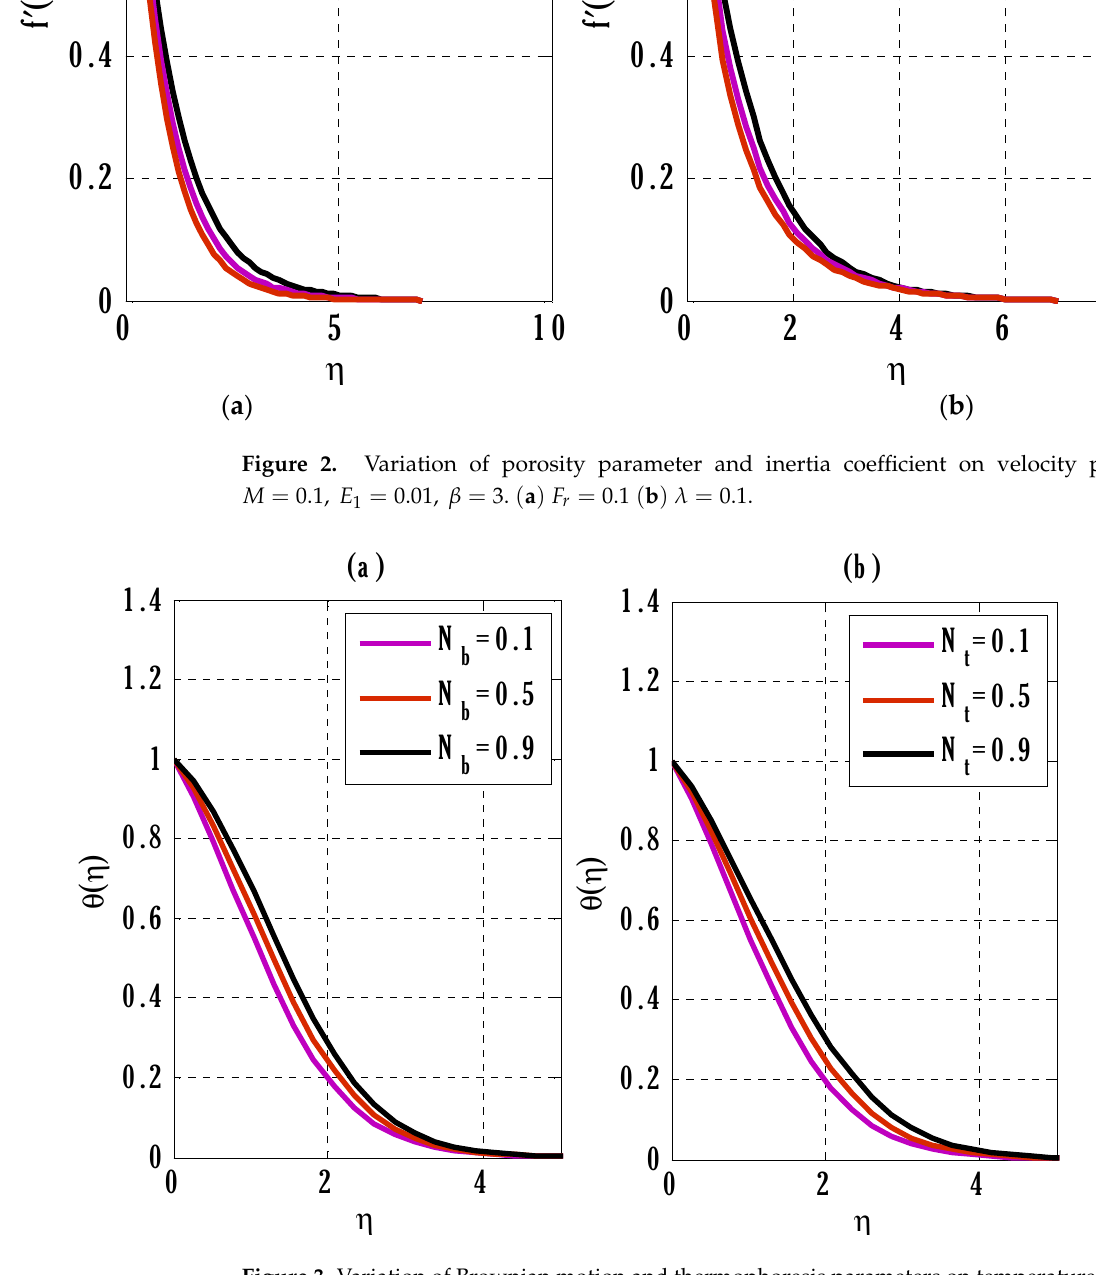
Figure 3. Variation of Brownian motion and thermophoresis parameters on temperature profile using β = 3, M = 0.1, λ = 0.1, F r = 0.1, P r = 0.7, S c = 0.5, E c = 0.4, R d = 0, E 1 = 0.01, ε 1 = 0.9, ε 2 = 0.5, γ = 0.1. ( a ) N t = 0.1 ( b ) N b = 0.1 . Figure 4 displays the temperature profile by varying the Prandtl and Eckert numbers. Temperature profile falloffs and develops by escalating the Prandtl and Eckert numbers, respectively. Since the Prandtl number and thermal diffusivity are inversely related, an